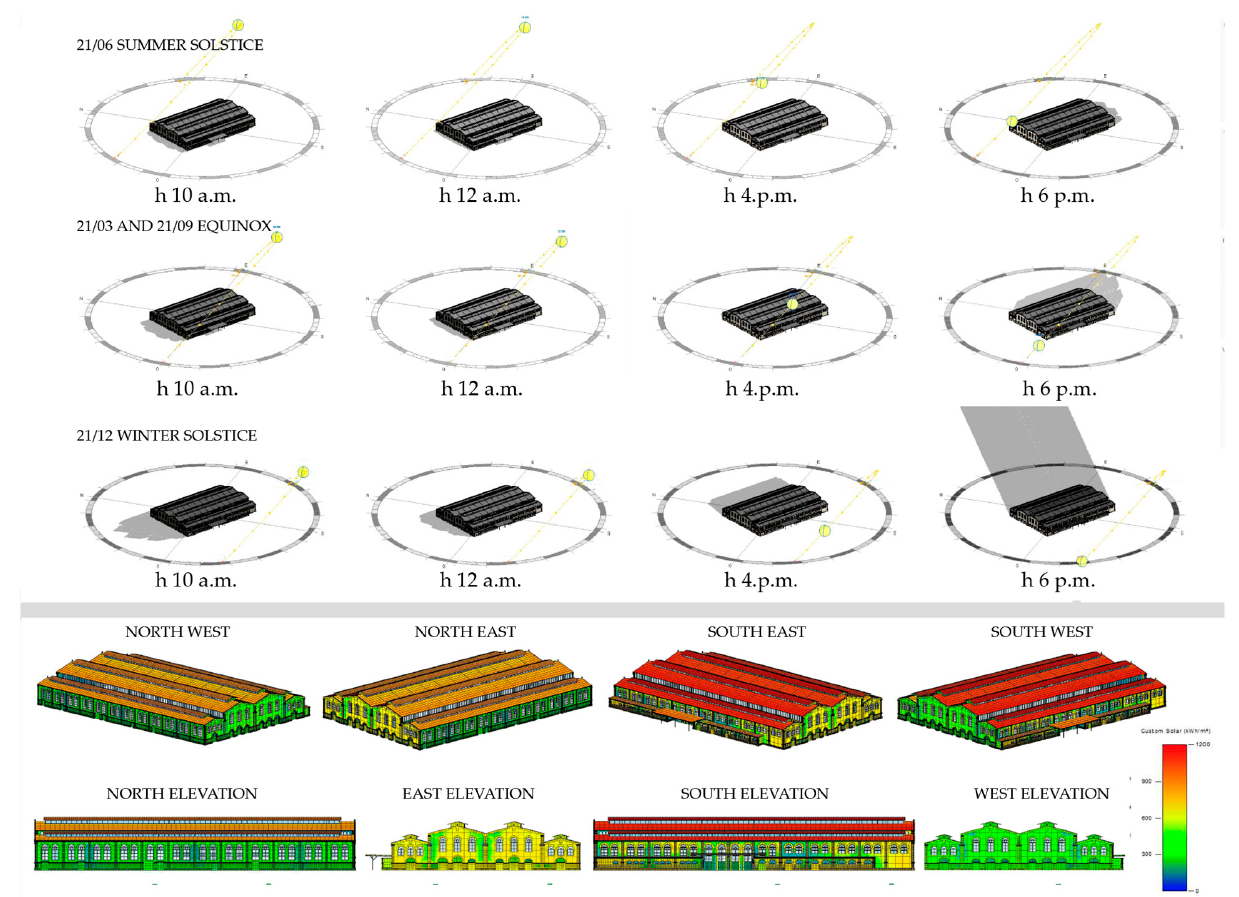
Figure 4. Solar analysis of the “Nave de Talleres Generales”.